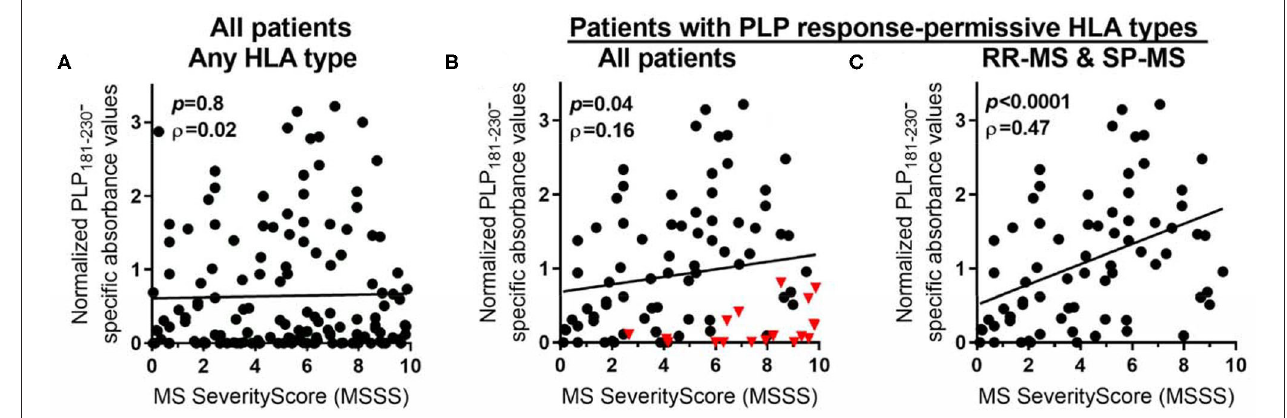
FIGURE 5 | Spearman rank correlation between levels of anti-PLP antibodies (as determined in Figure 1 ) and MSSS in: (A) all MS patients, irrespective of their HLA type; (B) all MS patients who carry PLP response-permissive HLA types (red triangles indicate PP-MS patients); and (C) RR-MS and SP-MS patients who carry PLP response-permissive HLA types. The P -value for each correlation and the Spearman ρ (rho) value are shown in each